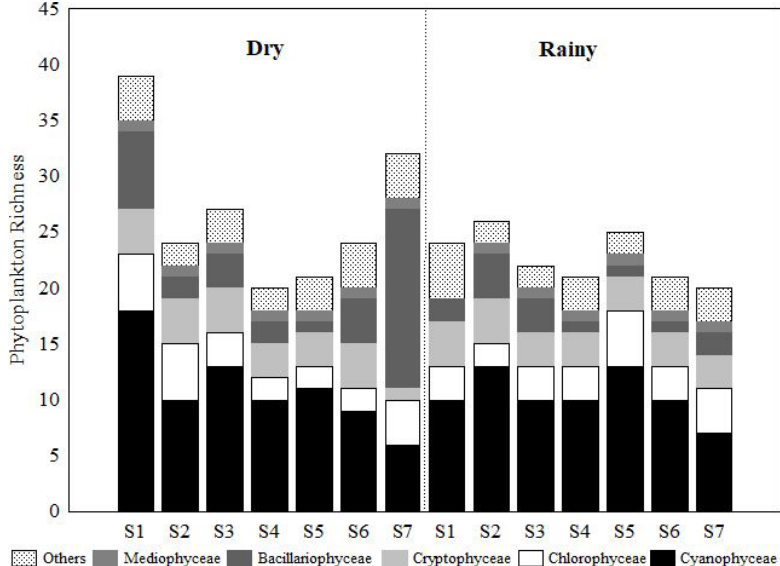
Figure 5. Spatial and temporal variation of the phytoplankton richness in the João Leite reservoir, GO, Brazil during a dry and rainy period.